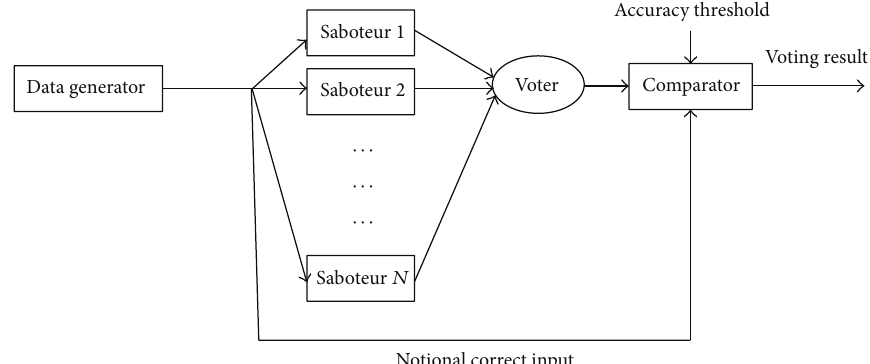
Figure 1: The experimental test